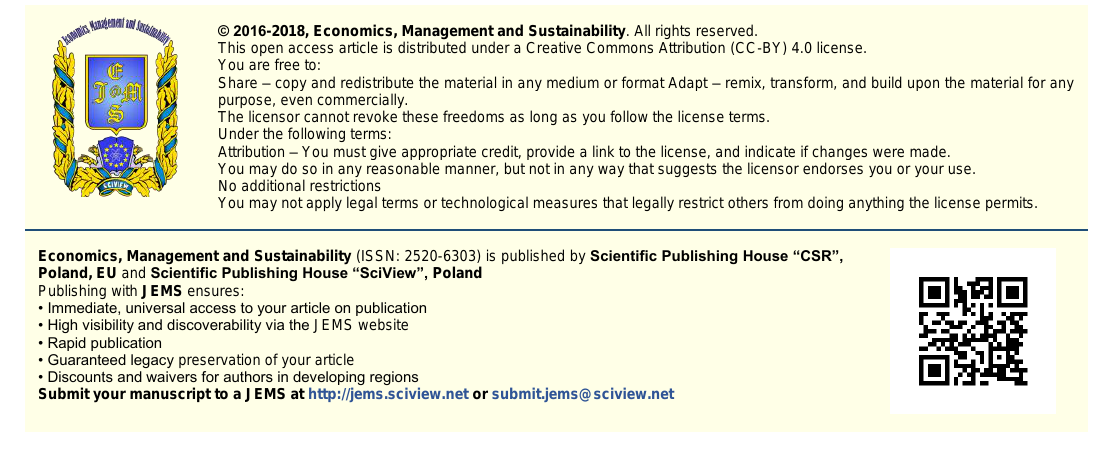
Real estate company